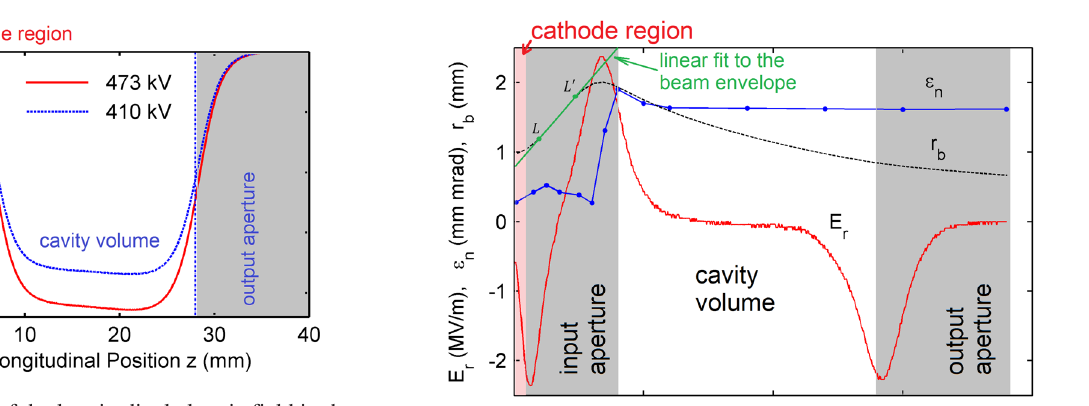
FIG. 11. The profile of the longitudinal electric field in the gun vs. distance. The simulation is perform with EGUN for the whole interaction region from the cathode, z ¼ 0 mm, to the end of output aperture of the cavity, z ¼ 38 mm. The electric field on the cathode produced by the HV pulser is 10 MV = m. The aperture region extends from z ¼ 1 mm to z ¼ 7 mm, where the absolute value of the field has an extremum.